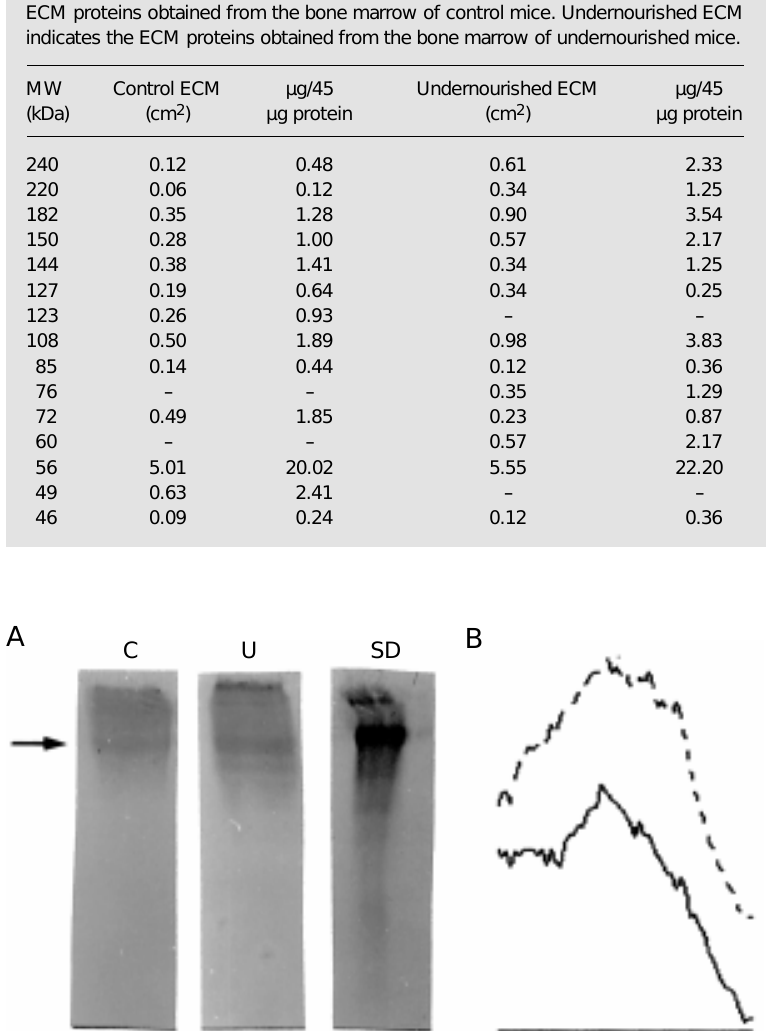
Table 2 - Comparative profile of bone marrow protein bands in control and undernour- ished mice.